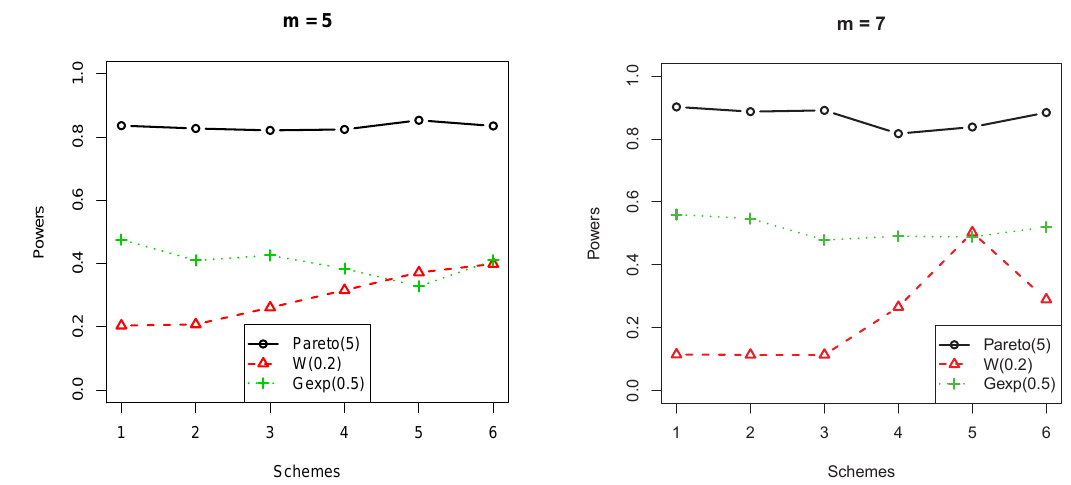
Figure 1. Powers of different schemes for the monotone decreasing hazard function for the ˆCRKL test, in the case of n = 10, m = 5 and 7.